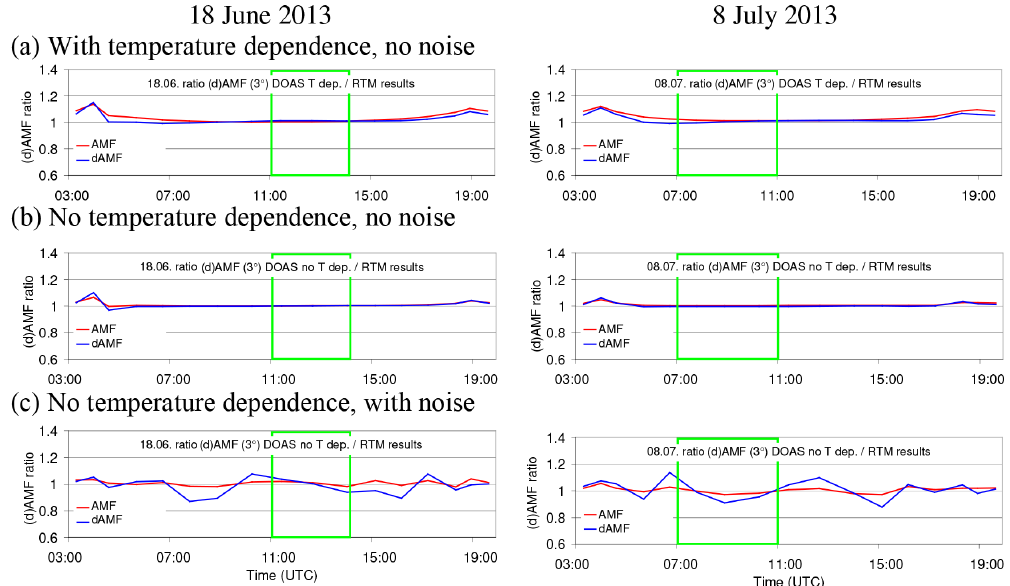
Figure 12. Ratios of the O 4 (d)AMFs derived from synthetic spectra vs. those obtained from radiative transfer simulations at 360nm for both selected